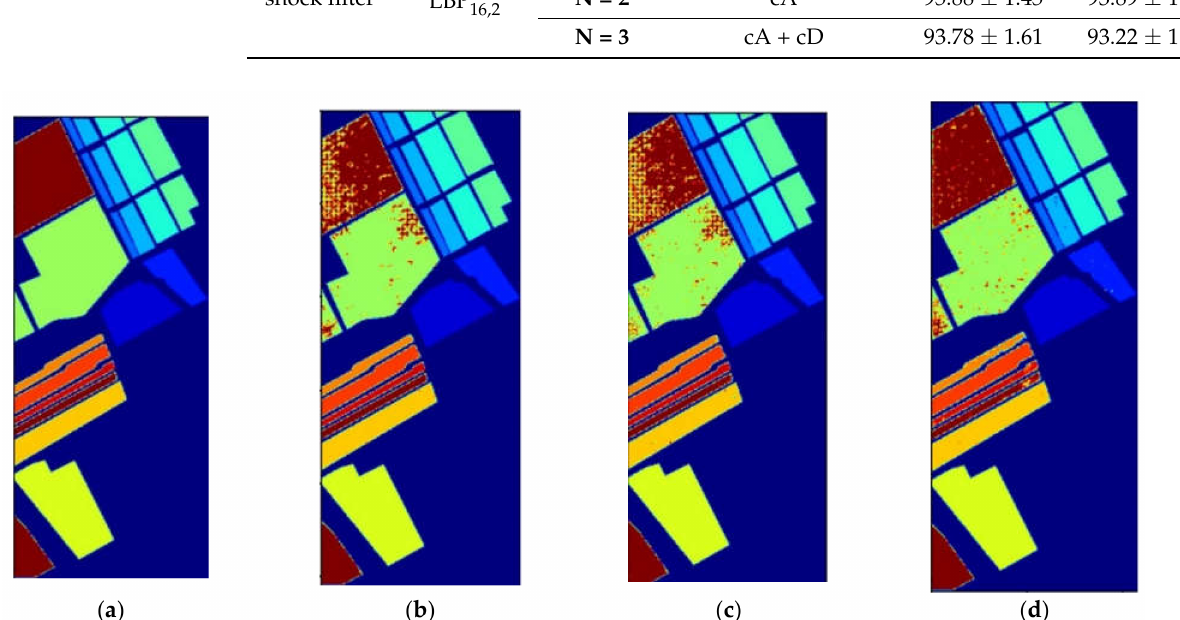
Figure 15. Classification maps obtained for the Salinas dataset with a controlled sampling strat- egy based on w3 window size for the training set, for N = 1 wavelet transform level and LBP riu2 ( a ) Reference map, ( b ) TV filtering, ( c ) CSSWHTV filtering, ( d ) anisotropic diffusion and shock filter-based